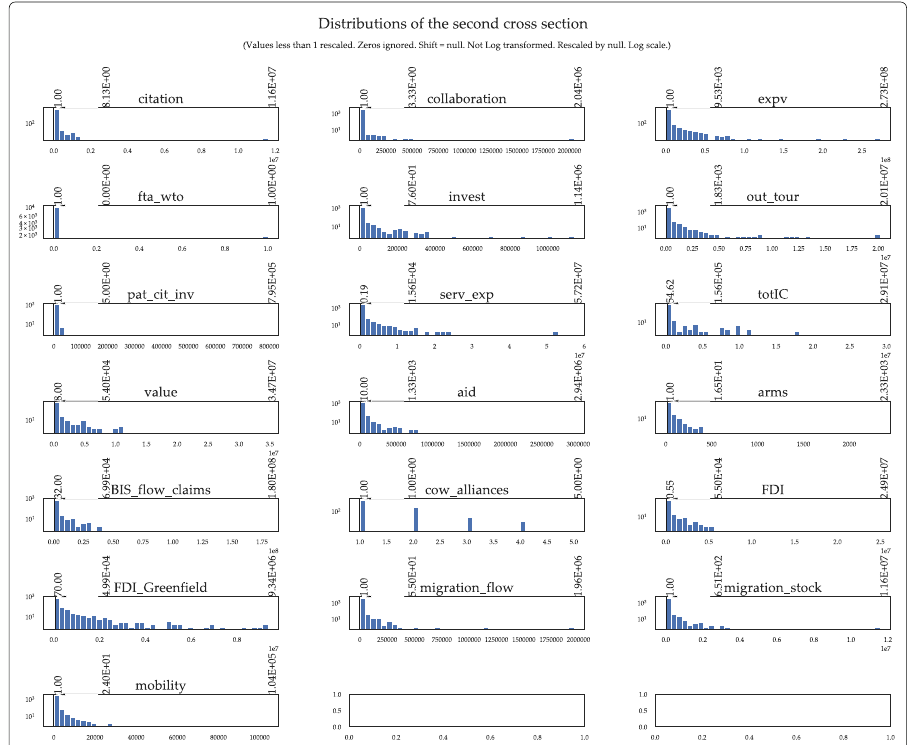
Fig. 14 Positive weights distribution in each layer of the cross section in 2010. Values rescaled to 1 if lower than 1. Logarithmic scale on the y axis